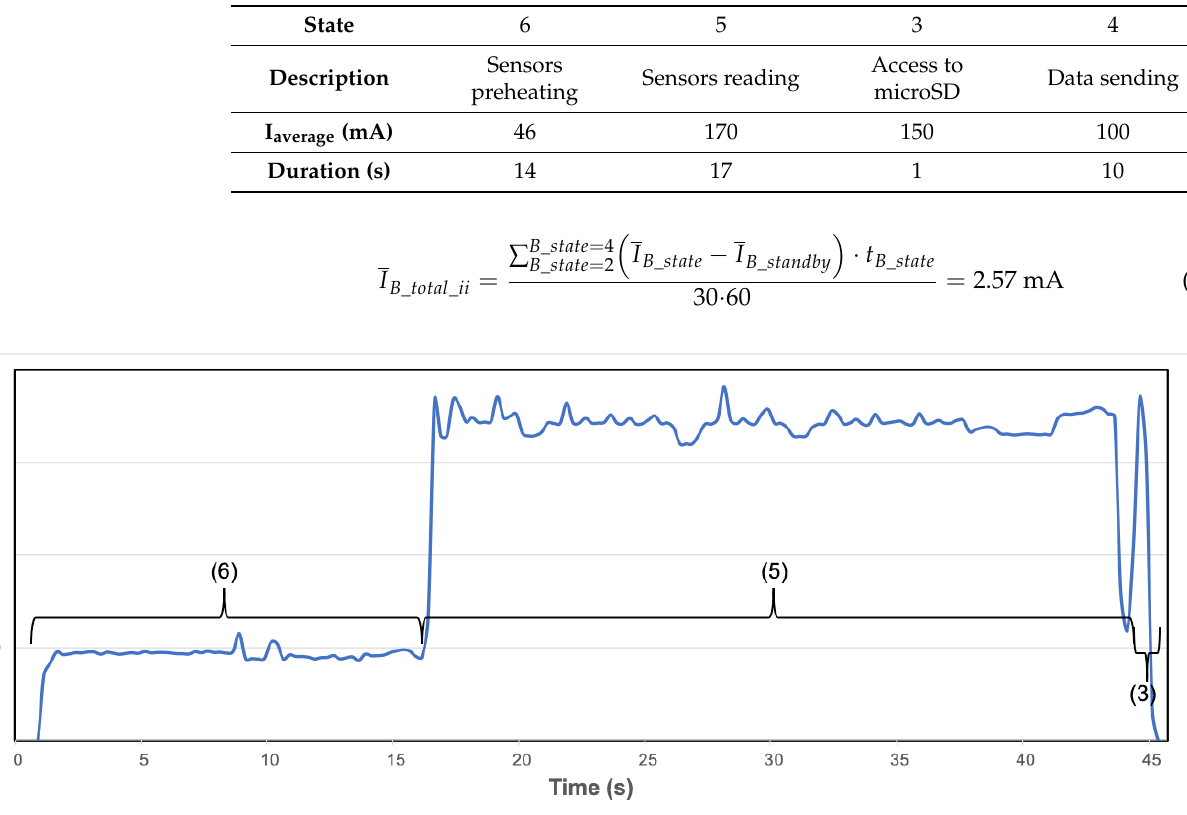
Figure 10. Node B—mode (iii): Sensor reading without data sending mode (every 30 min). Table 8. Description of functional states of node B—mode (iii).